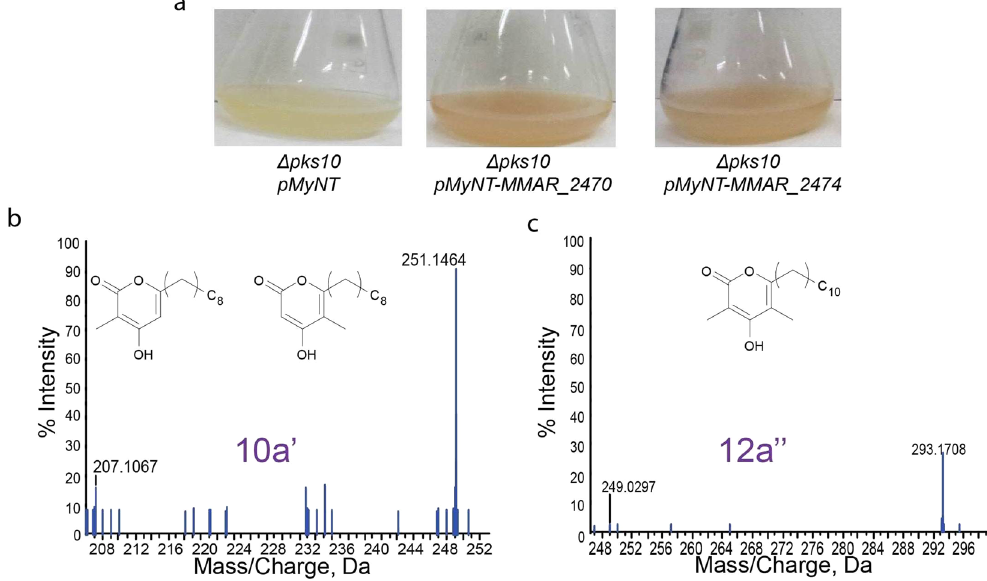
Figure 7. Over-expression of MMAR_2470 and MMAR_2474 proteins in ∆ pks10 Mycobacterium smegmatis strain. ( a ) Planktonic cultures over-expressing MMAR_2470 and MMAR_2474 proteins show brownish coloration. Triple-TOF HRMS metabolomic analysis of extracted culture filtrates of planktonic cultures over- expressing the Mmar type III PKSs identified ( b ) mono- and ( c ) di-methylated alkyl-triketide α -pyrones.